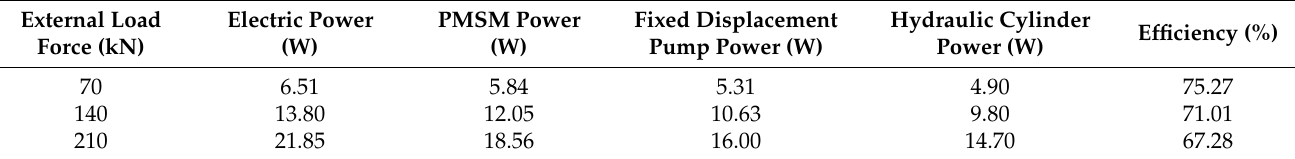
Table 2. Power values and transfer efficiency of energy states under different load